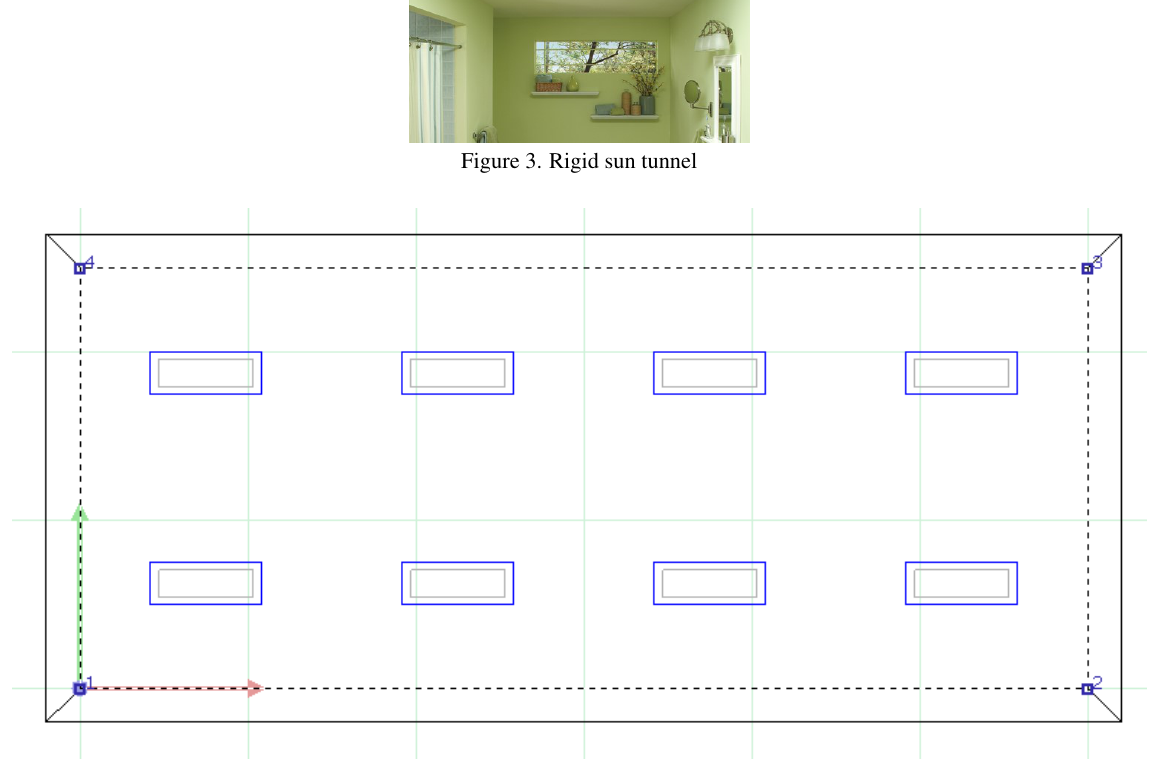
Figure 4. Luminaire Distribution Using